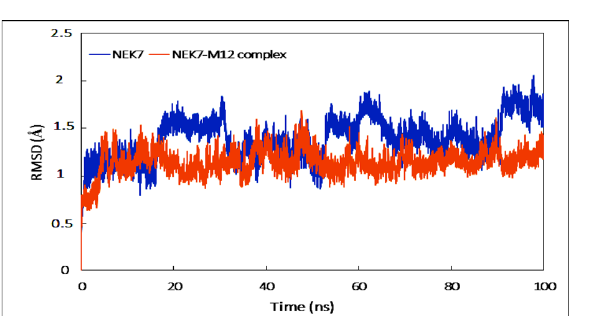
Figure 8. SeeSAR analysis of potent derivatives and standard; ( A ) M7, ( B ) M8, ( C ) M12, D) Dabrafenib, red colored coronas are indicating unfavorable features whereas blue colored coronas are indicating favorable contributions and colorless coronas are showing no contribution of structural components.